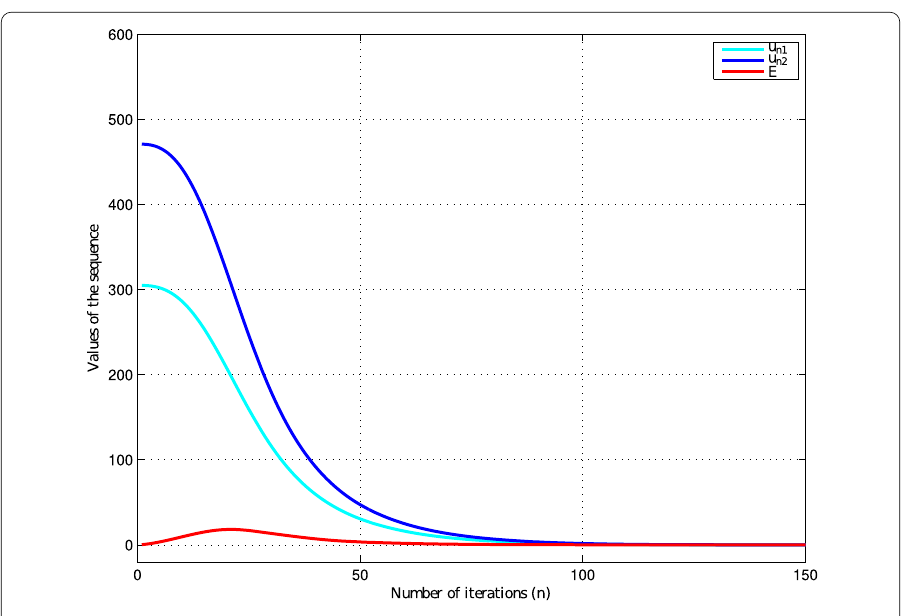
Figure 2 Convergence result of Theorem 3.5 with starting point of Case